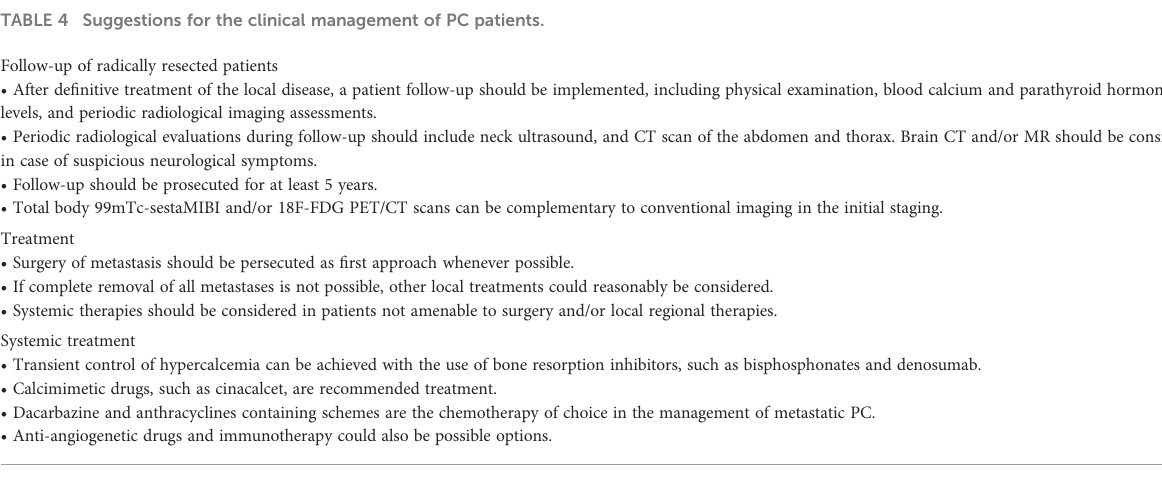
TABLE 4 Suggestions for the clinical management of PC patients. Follow-up of radically resected patients (cid:129) After de fi nitive treatment of the local disease, a patient follow-up should be implemented, including physical examination, blood calcium and parathyroid hormone levels, and periodic radiological imaging assessments. (cid:129) Periodic radiological evaluations during follow-up should include neck ultrasound, and CT scan of the abdomen and thorax. Brain CT and/or MR should be considered in case of suspicious neurological symptoms. (cid:129) Follow-up should be prosecuted for at least 5 years. (cid:129) Total body 99mTc-sestaMIBI and/or 18F-FDG PET/CT scans can be complementary to conventional imaging in the initial staging. Treatment (cid:129) Surgery of metastasis should be persecuted as fi rst approach whenever possible. (cid:129) If complete removal of all metastases is not possible, other local treatments could reasonably be considered. (cid:129) Systemic therapies should be considered in patients not amenable to surgery and/or local regional therapies. Systemic treatment (cid:129) Transient control of hypercalcemia can be achieved with the use of bone resorption inhibitors, such as bisphosphonates and denosumab. (cid:129) Calcimimetic drugs, such as cinacalcet, are recommended treatment. (cid:129) Dacarbazine and anthracyclines containing schemes are the chemotherapy of choice in the management of metastatic PC. (cid:129) Anti-angiogenetic drugs and immunotherapy could also be possible